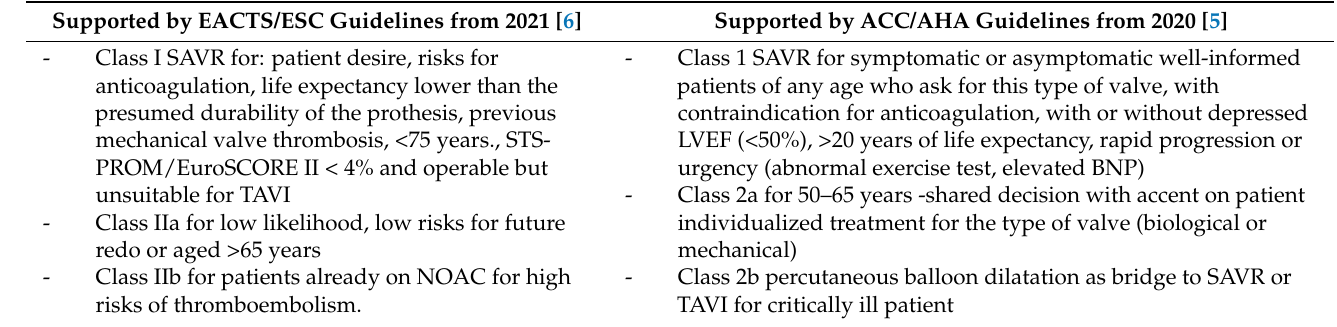
Table 5. Decision Making Algorithm. Bio-SAVR for middle-aged